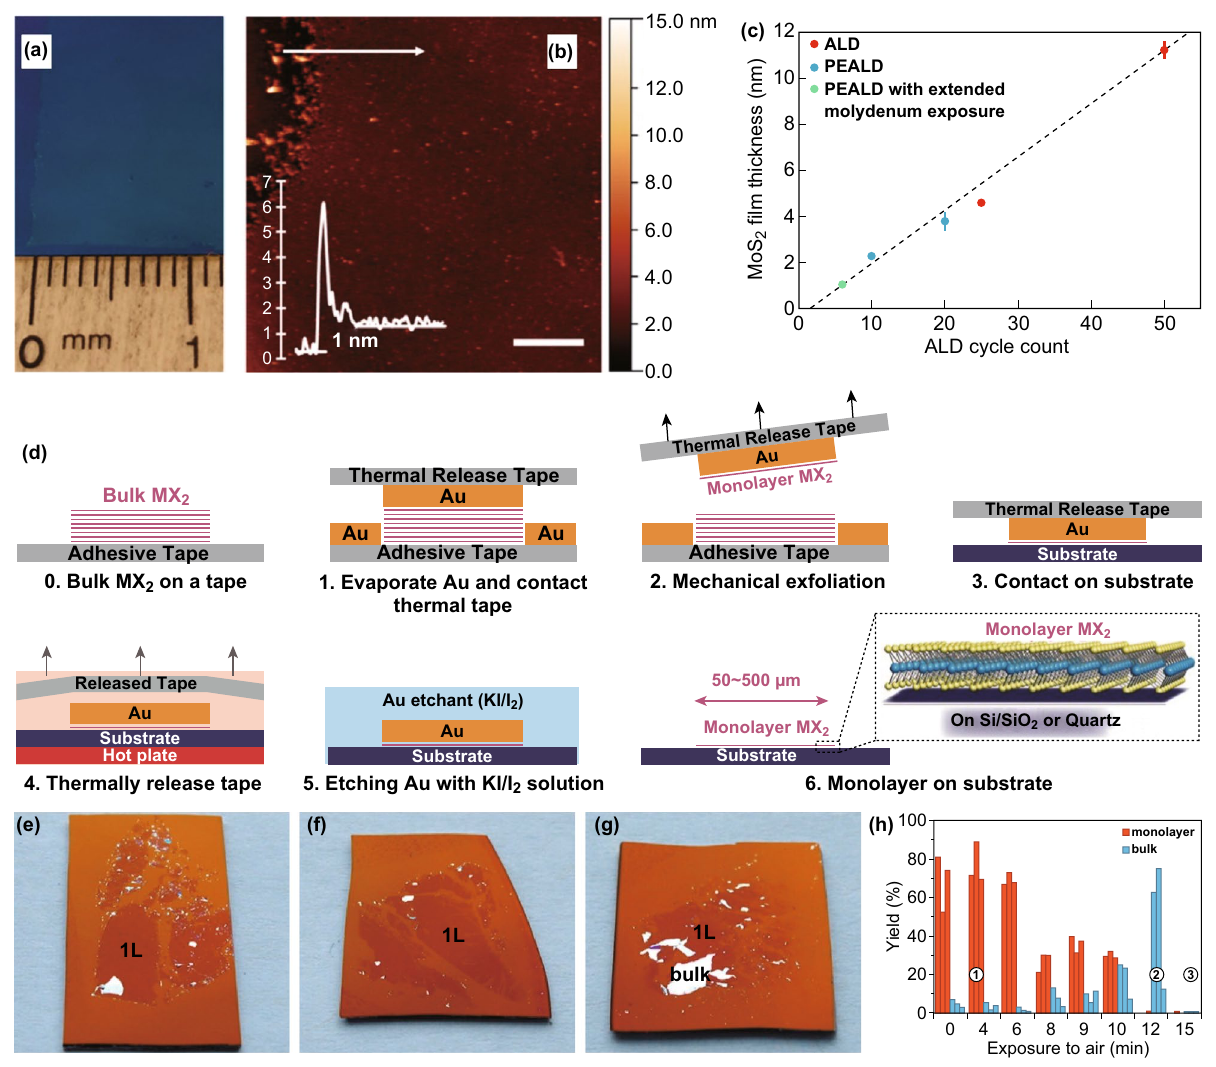
Fig. 4 Large-area synthesised TMDCs by ALD, PLD and ME. a Optical image of 2D MoS 2 on 300 nm SiO 2 /Si substrate showing centimetre- scale uniformity achieved with ALD and the post-sulfidation process. b AFM image with a height profile of monolayer MoS 2 . c Error bar diagram of the thickness of MoS 2 film during ALD and PEALD process. Adapted with permission from Ref. [34]. Copyright 2017 American Chemical Society. d Schematic illustration of the Au exfoliation process. e – g Optical images of a large-scale MoS 2 on 7.5 nm Au at different periods after the Au exposure to air flakes. h Histogram of the monolayer (red) and bulk (blue) yields at different times. Adapted with permis- sion from Ref. [85]. Copyright 2018 American Chemical Society. (Color figure